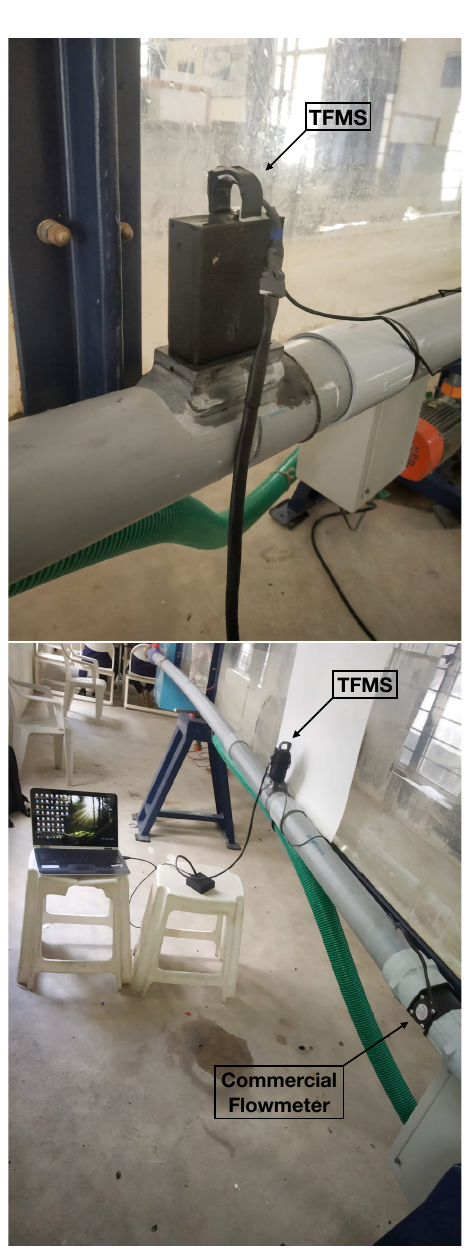
Fig. 3. Experimental setup, (a) TFMS installed in the pipeline, (b) TFMS installed in the pipeline along with the commercial flow meter.